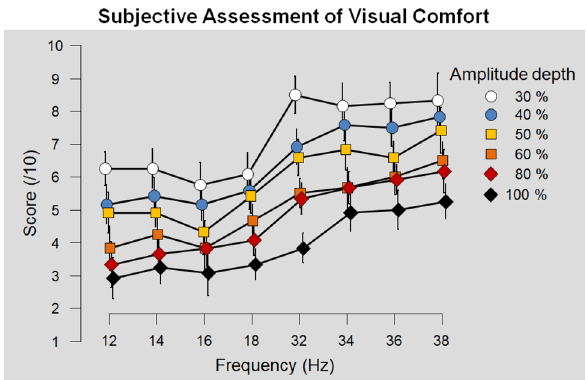
Figure 3. Experiment 2: subjective visual comfort score across RVS frequency ranges (low: 12, 14, 16, 18; high: 32, 34, 36, 38 Hz) for each RVS amplitude depth (30, 40, 50, 60, 80 and 100% of the maximal